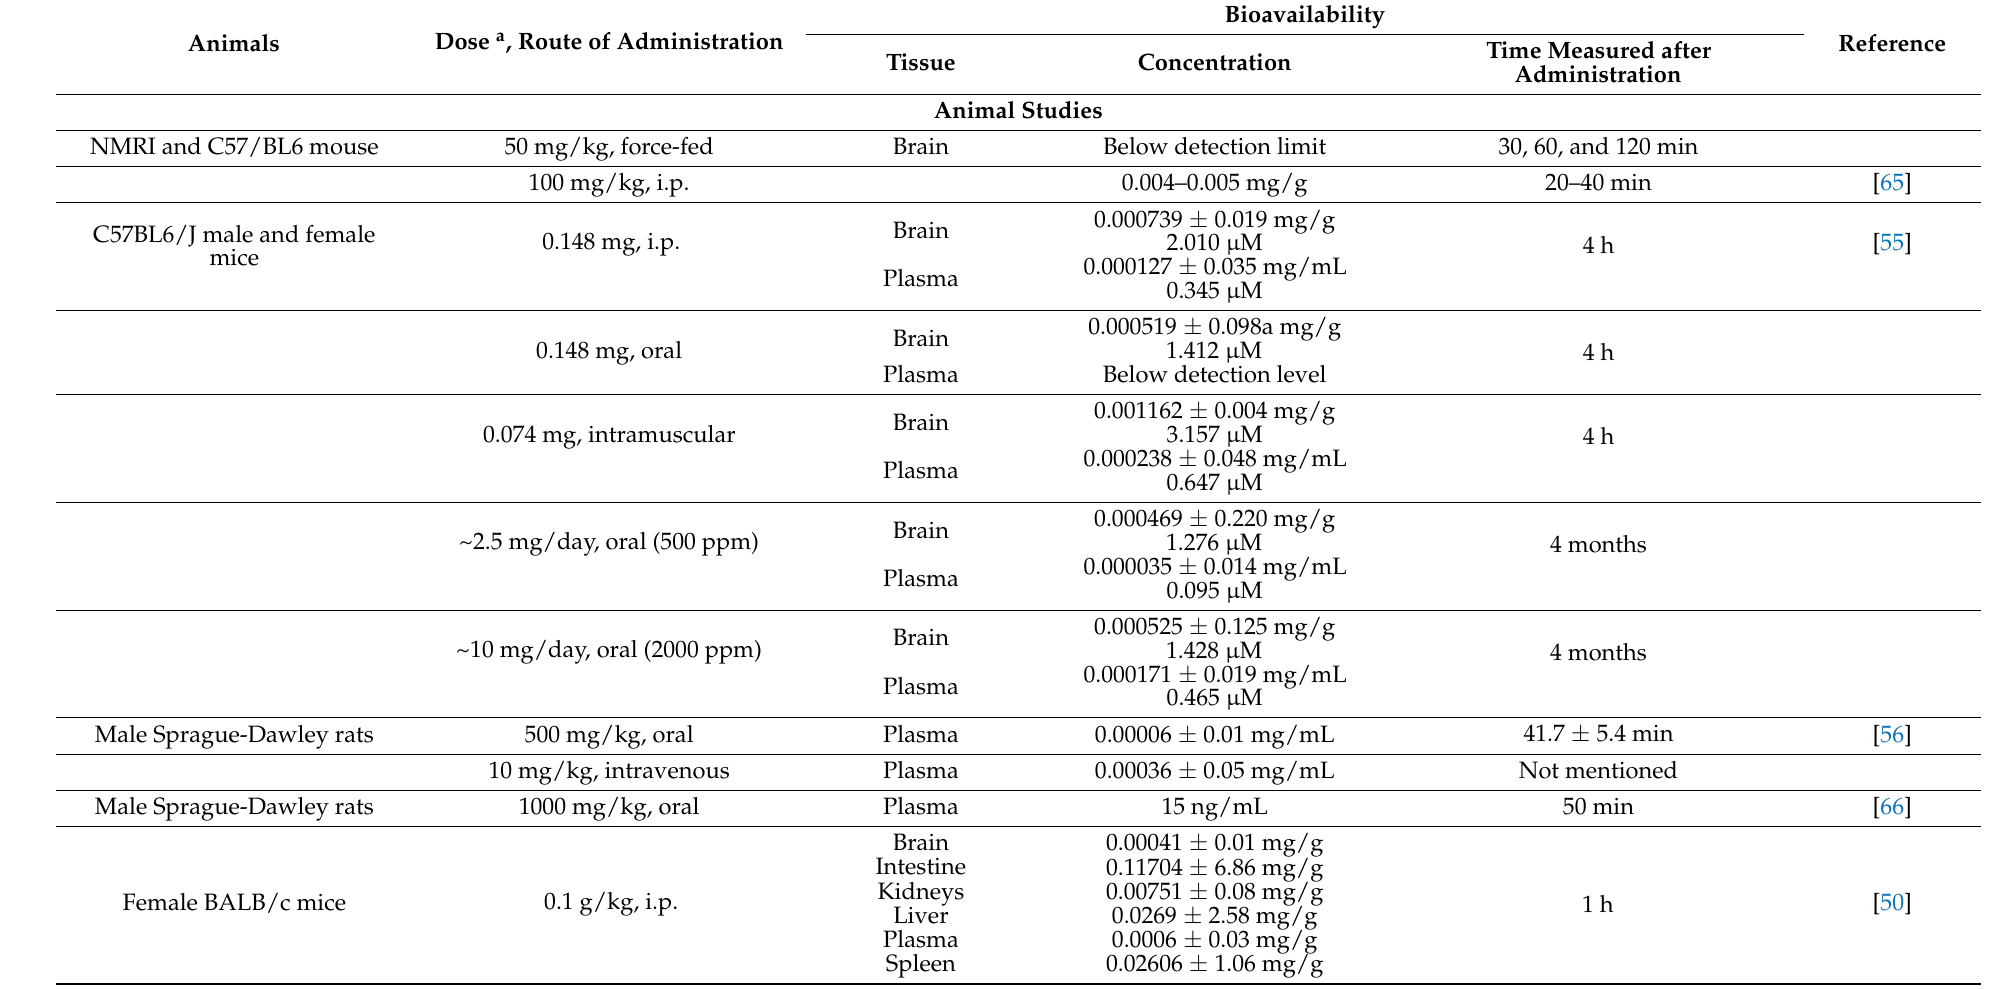
Table 1. Serum and tissue levels of curcumin in animal and clinical